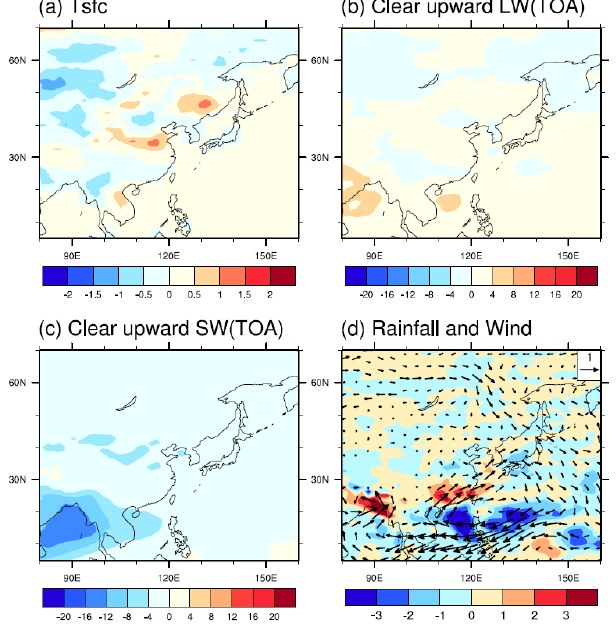
Figure 14. As Fig. 13 but showing the contribution from the di- rect radiative effect of dust to the future–present differences (repre- sented by (AEts − AE) – (AEnodts − AEnod)) in JJA in (a) surface temperature (K), (b) clear-sky upward longwave radiation at top of atmosphere (Wm − 2 ) , (c) clear-sky upward shortwave radiation at top of atmosphere (Wm − 2 ) and (d) rainfall (shading, mmday − 1 ) and 850hPa wind (vectors, ms − 1 ) .